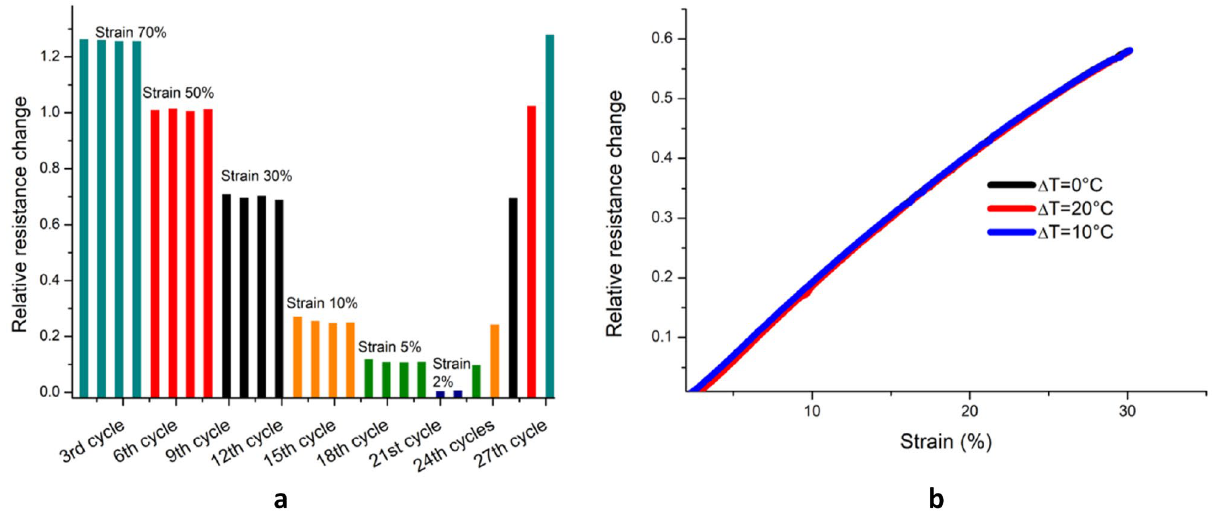
Figure 5. Plot between applied strain from 2 to 70% and corresponding induced resistance change for repeated cycles ( a ), strain sensing for different ΔT set across the junctions to ensure the null cross over sensitivity ( b